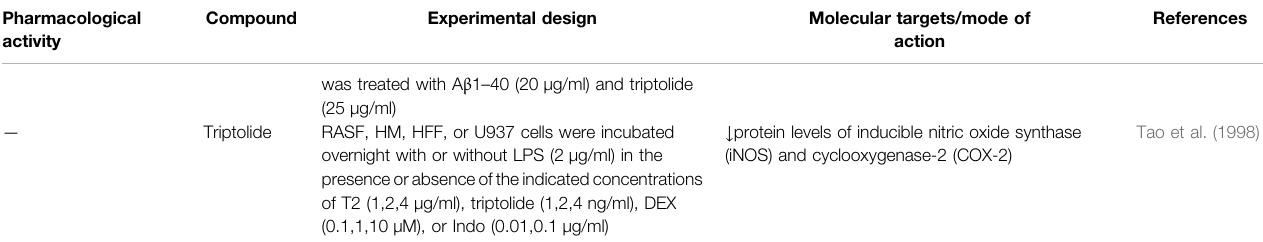
TABLE 4 | ( Continued ) Pharmacological effects of different compounds isolated from Tripterygium hypoglaucum in vitro